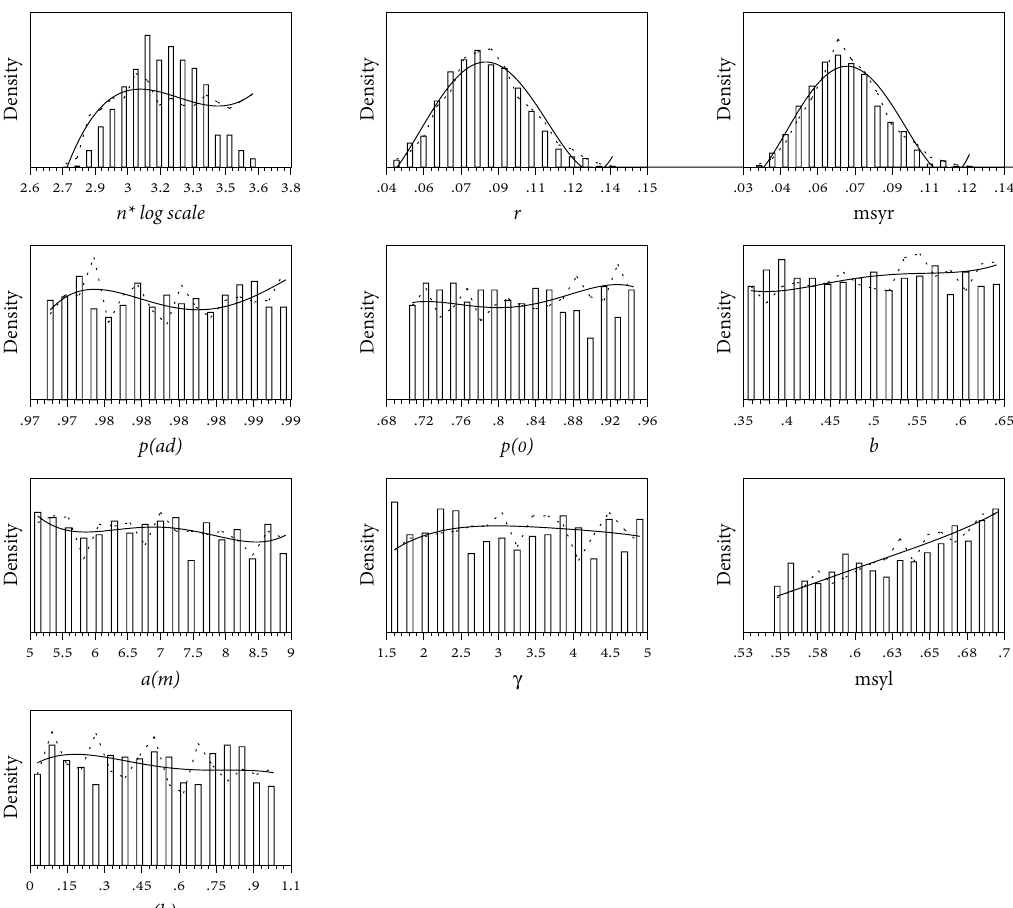
Fig. 4. Realised prior (dashed curve; solid curve fitted polynomial) and posterior (bars) parameter distributions for density-regulated growth in East Greenland walruses (model nE). For parameter symbols see Table